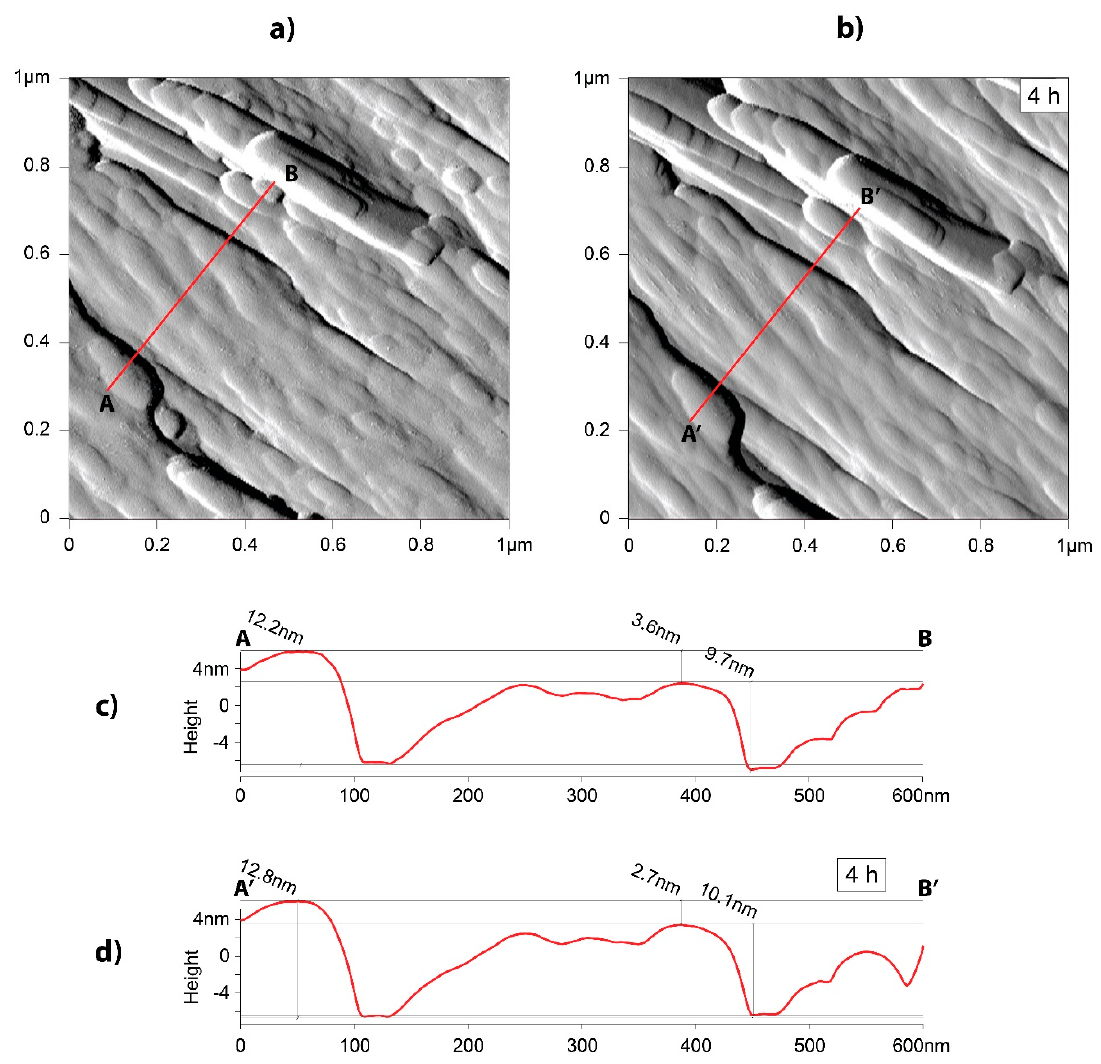
Figure 8. AFM images in amplitude retrace of same area of erionite surface at 37 °C, ( a ) in water and ( b ) after 4 h of interaction in ALF (pH 4.34). Corresponding profiles of AB section ( c ) and A’B’ section ( d ). A differential dissolution of surface and particles removal is appreciable.